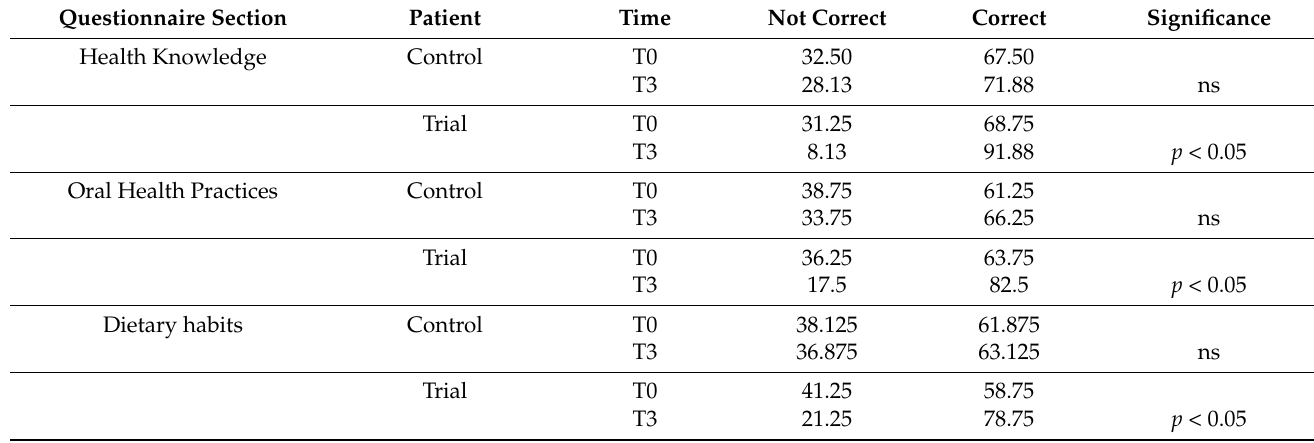
Table 5. Frequency distribution of correct and not correct answers in the various groups in the three sections of the survey. Questionnaire